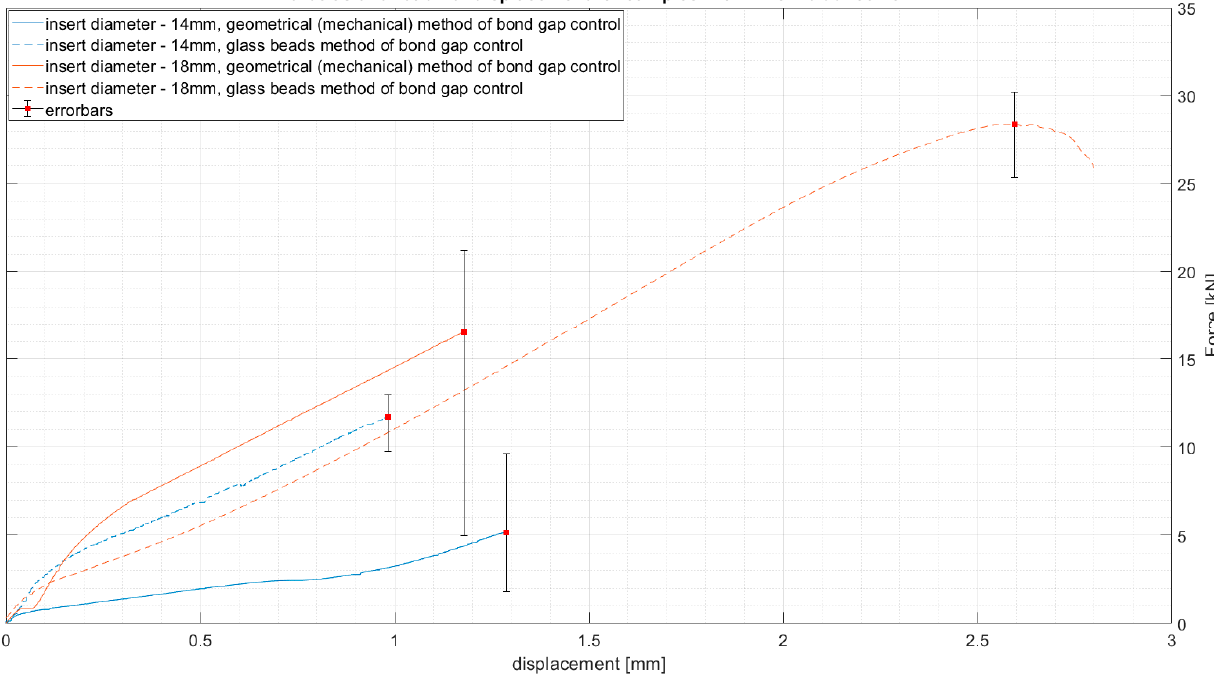
Figure 5. Force as a function of displacement for samples with EA 3425 adhesive. Table 4. Average results of ultimate “stress”.